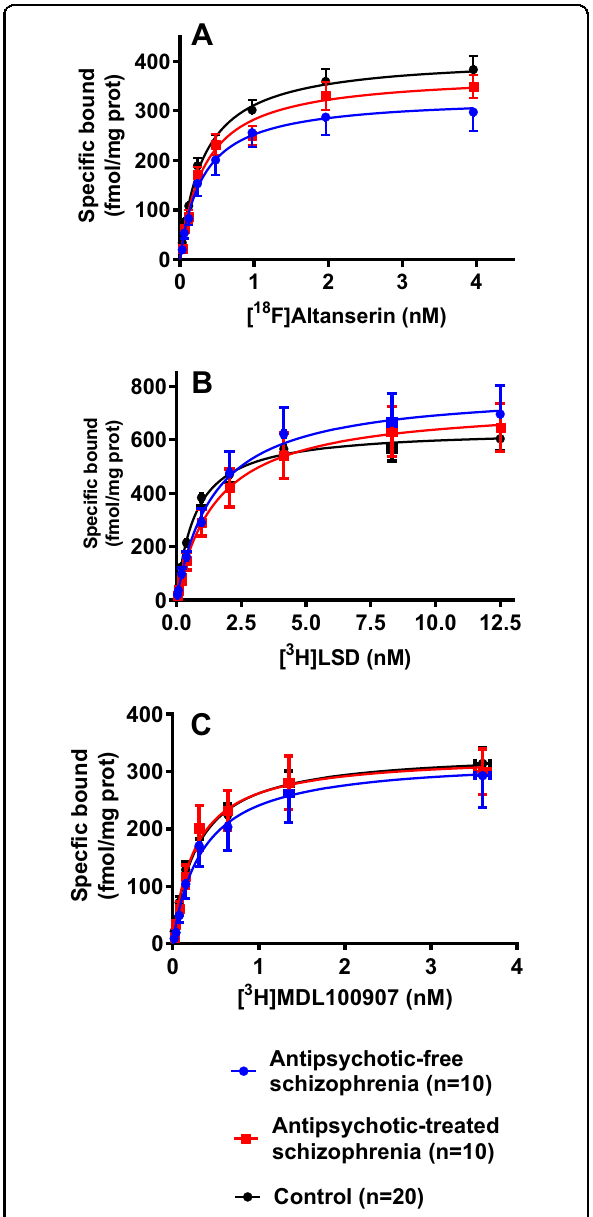
Fig. 3 Alterations of 5-HT 2A receptor density in schizophrenia. Saturation curves of the speci fi c [ 18 F]altanserin ( A ), [ 3 H]LSD ( B ) and [ 3 H]MDL100907 ( C ) binding to membranes of post-mortem frontal cortex from subjects with schizophrenia and presence of antipsychotic drugs in the blood at the time of death (antipsychotic-treated), subjects with schizophrenia and no antipsychotic drugs in the blood (antipsychotic-free), and matched control subjects. Each schizophrenia group was analysed vs. the respective control group, but in order to clarify, here the two control groups are shown together. The curves represent the best- fi t estimation generated by the non-linear co- analysis of individual results in each group. The density of 5-HT 2A Rs is expressed as the asymptote value ( B max ) of the radioligand bound. The af fi nity of the radioligand is expressed by the concentration of radioligand that promotes the half-maximal bound ( K d ). Points representing means were not used for statistical